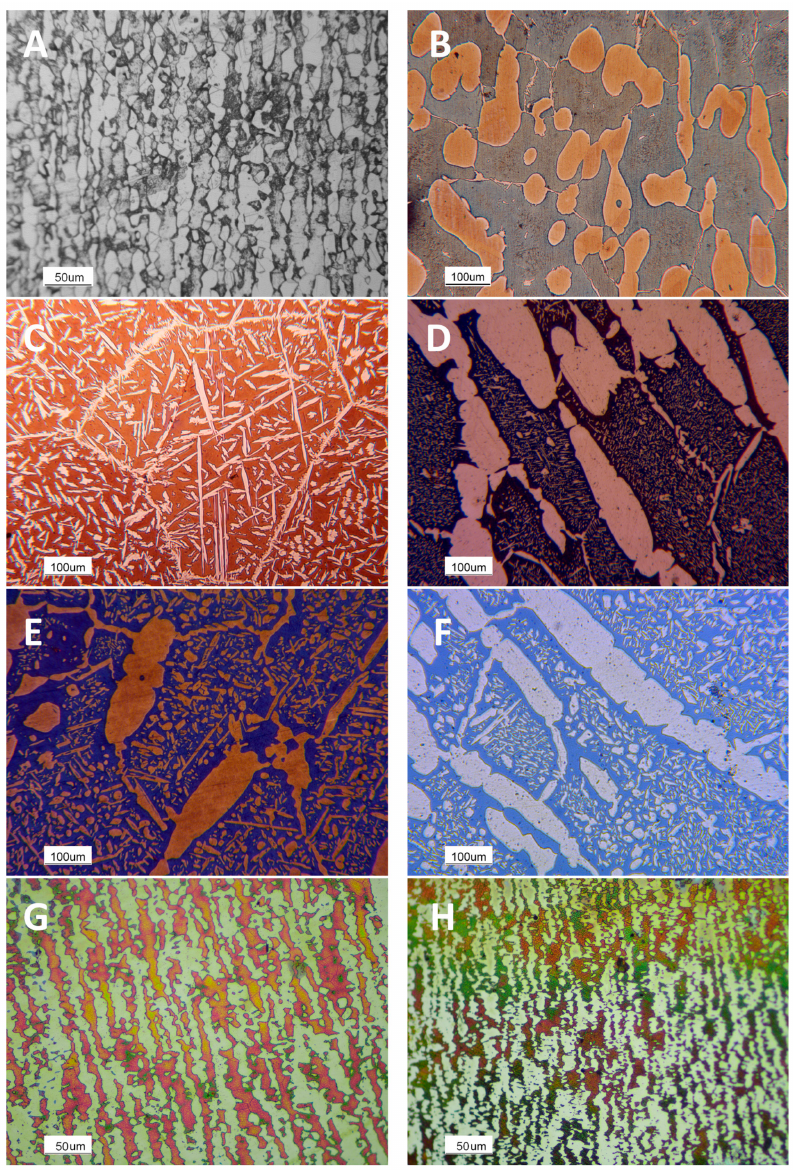
Figure 4. Samples microstructure through optical microscopy: the cold drawn reference specimen ( A ); the solution annealed at 1300 ◦ C ( B ); the solution annealed at 1400 ◦ C ( C ); the samples annealed at 1080 ◦ C for: 72 s/mm ( D ); 210 s/mm ( E ); and 360 s/mm ( F ); and the cold rolled samples with: 60% ( G ); and 90% ( H ) reduction